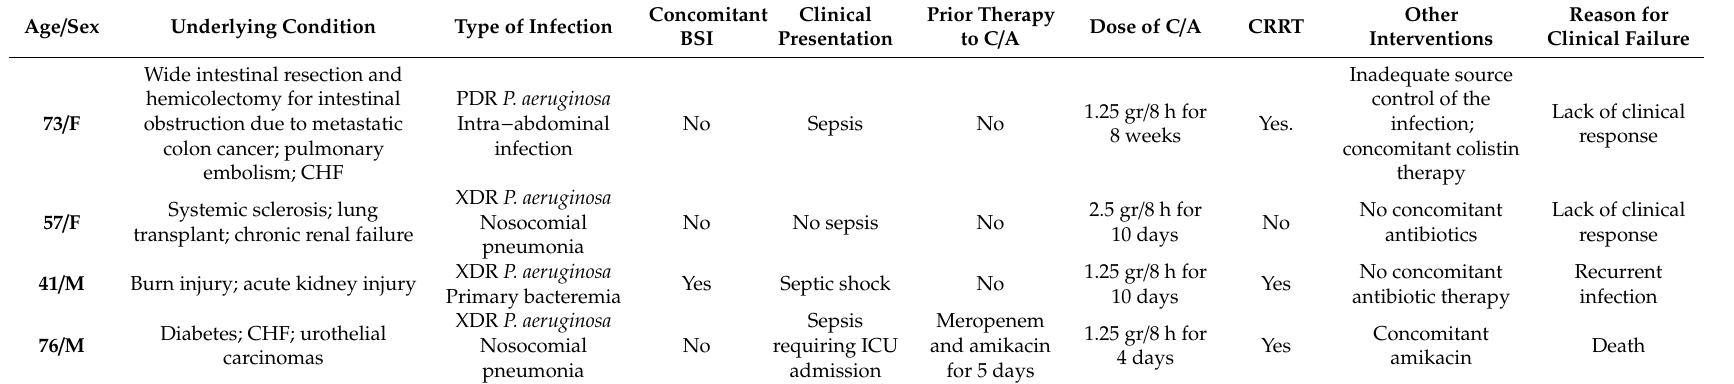
Table 5. Description of patients who experienced clinical failure.